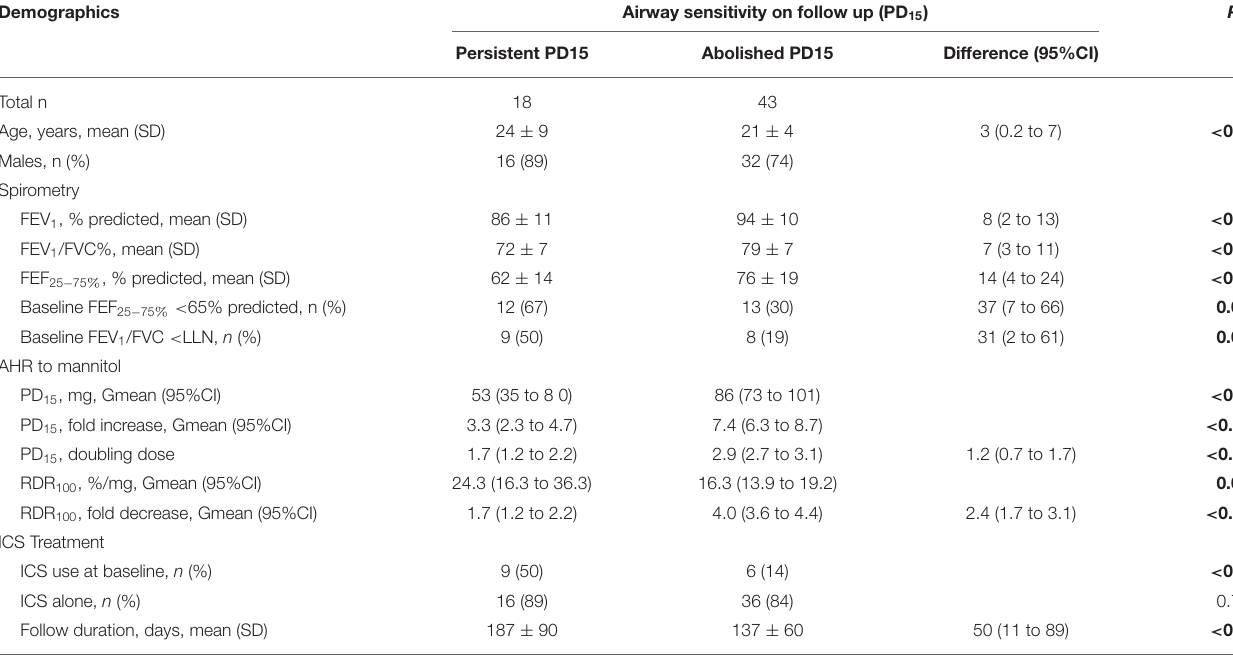
TABLE 7 | Moderate to Severe AHR (PD 15 < 155mg) at baseline; demographics and baseline lung function, AHR and ICS treatment, type, and duration.